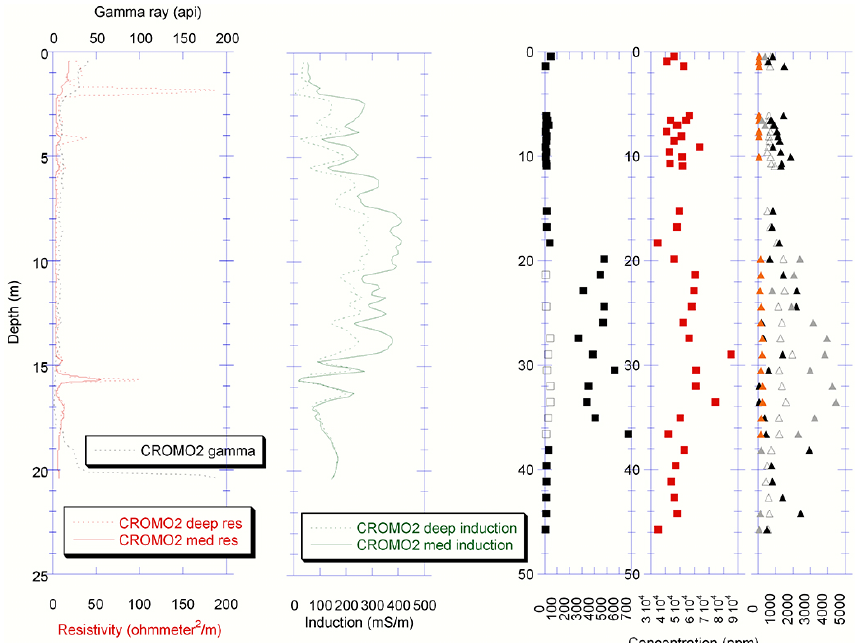
Figure 4. Geophysical logging results (temperature, gamma, induction, resistivity logs) for CROMO2, drilled about 1km west of CROMO1, in the Quarry Valley area at the McLaughlin Natural Reserve. In all plots, depth is plotted along the y axis, as meters below surface. Leftmost panel: this depth profile shows variation in gamma ray signal in units of api; U, Th, K-concentrating lithologic units drive values up. Also shown are observed resistivity data in units of Ω m 2 m − 1 ; medium resistivity conveys information about resistivity near tool, while deep resistivity conveys information about resistivity far from tool in the surrounding formation. Left-middle panel: this depth profile shows observed induction in units of mSiemensm − 1 , a measure of induced electrical field in formation rocks; medium induction conveys information about conductivity near tool, while deep induction conveys information about conductivity far from tool. Right trio of panels: bulk powder XRF geochemical data for selected analytes (Sr, Rb, Fe, Mn, Cr, V, Ti) are shown in a trio of plots; Sr data are filled squares, Rb data open squares, Fe data red squares, Mn data open triangles, Cr data black triangles, V data brown triangles, and Ti data gray triangles. Numerical data presented in Supplement Table